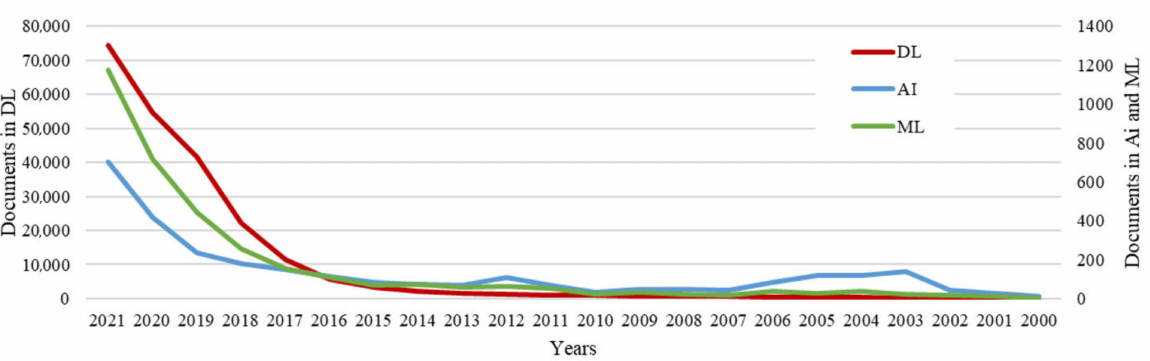
Figure 1. The number of review studies devoted to artificial intelligence (AI), machine learning (ML), and deep learning (DL) indexed in Scopus.